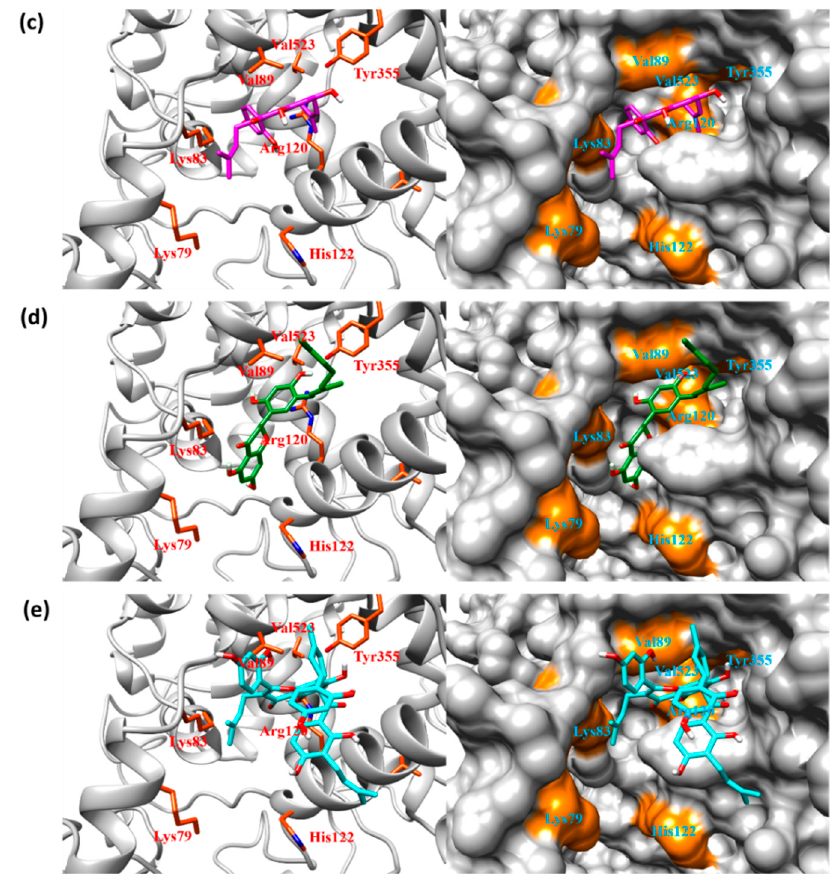
Figure 2. Binding poses with the lowest total interaction energy for ( a ) kuwanon A, ( b ) kuwanon B, ( c ) kuwanon C, ( d ) kuwanon E, and ( e ) kuwanon H. All kuwanon derivatives can block the entrance of the celecoxib active site. The orange-colored surface represents the residues at the gate of the cyclooxygenase (COX) activity as calculated with the five lowest pair interaction energies, using pair interaction energy decomposition analysis (PIEDA).